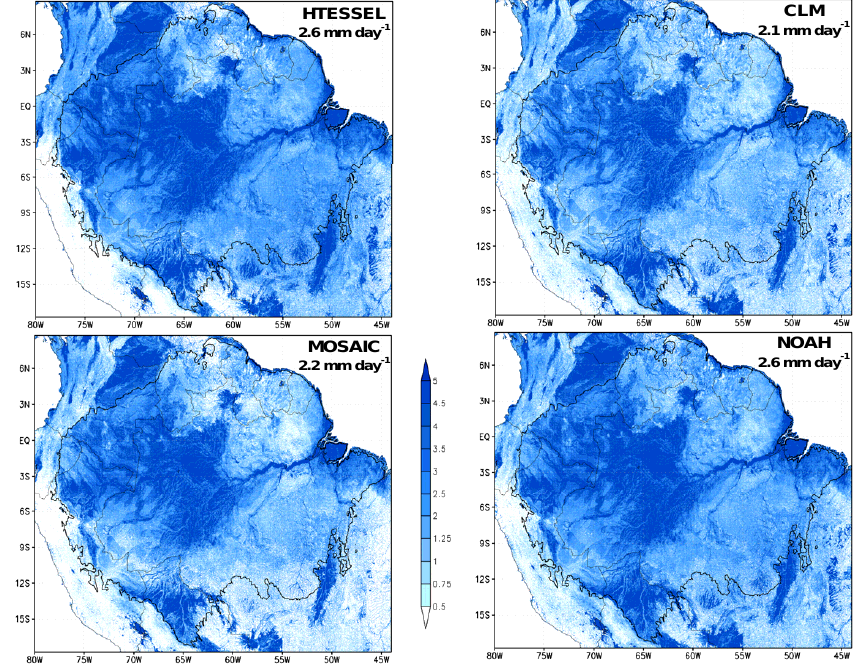
Fig. 15. Maps of potential capillary flux (mm day -1 ), showing Amazonian mean, based on the four WTD simulations.